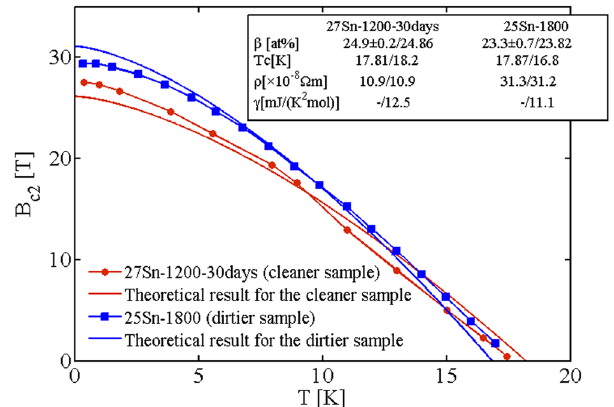
Figure 7. Temperature dependence B c2 ( T ) for two homogenous off-stoichiometric Nb 3 Sn samples, and comparison to experiments 11